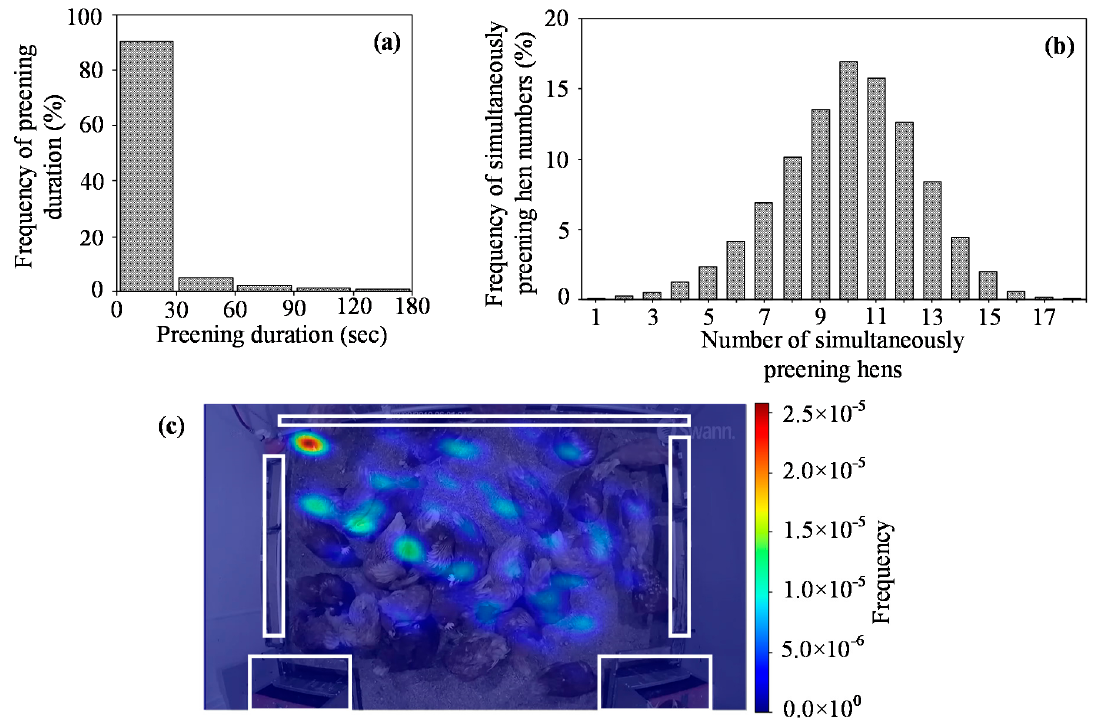
Figure 8. Preening behavior measurement during 6:00–6:30 am for 38-week-old hens. ( a ) Frequency of preening duration. ( b ) Frequency of simultaneously preening numbers. ( c ) Heat map for the location of preening birds. The drinker, feeder and nest box are marked as the white rectangles on the top, middle and bottom, respectively. The non-unit frequency represents the probability for birds preening at specific locations and is calculated by Standard Gaussian Kernel Density Estimation